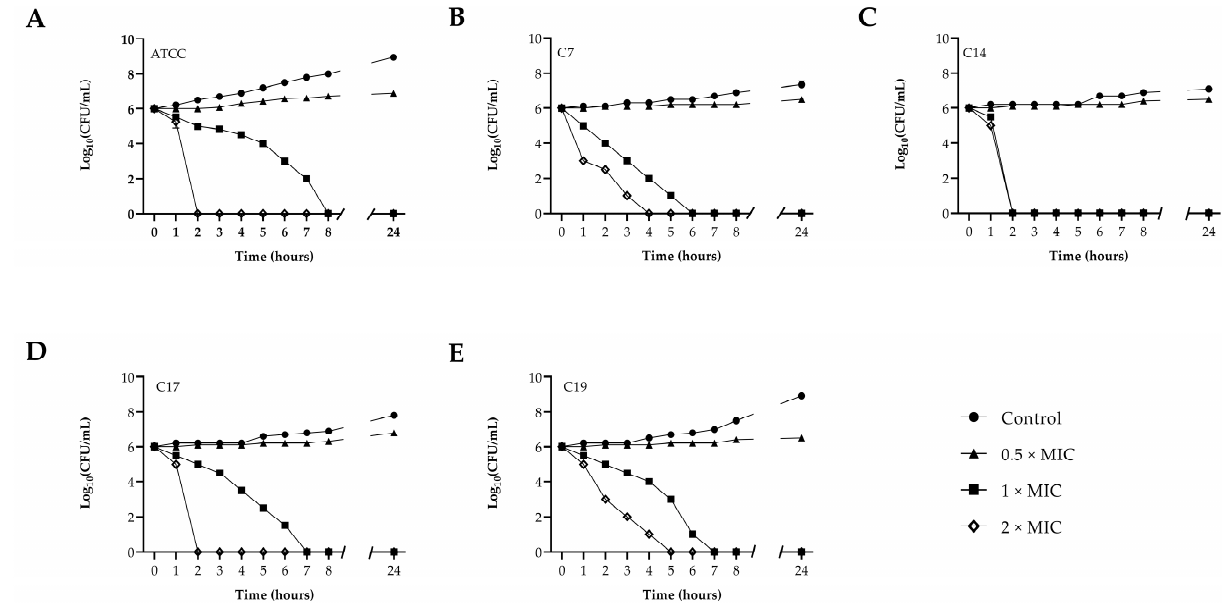
Figure 2. Time-kill kinetics of PLA against C. albicans ATCC90028 (panel A ) and fluconazole-re- C. albicans clinical isolates (panel B – E sistant C. albicans clinical isolates (panel B – E ).